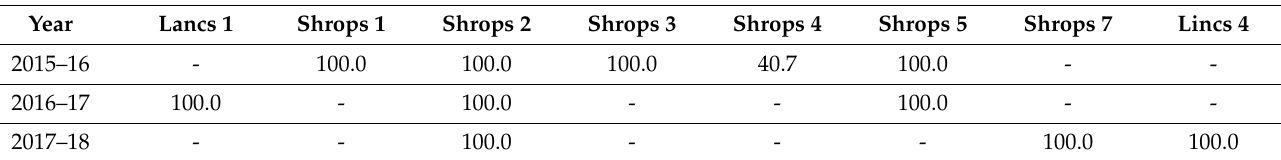
(B) the percentage of permutations in which a significant correlation between the pairs of matrices was not recorded but one or both assessments were taken when slug surface activity resulted in mean catches of <4 slugs per